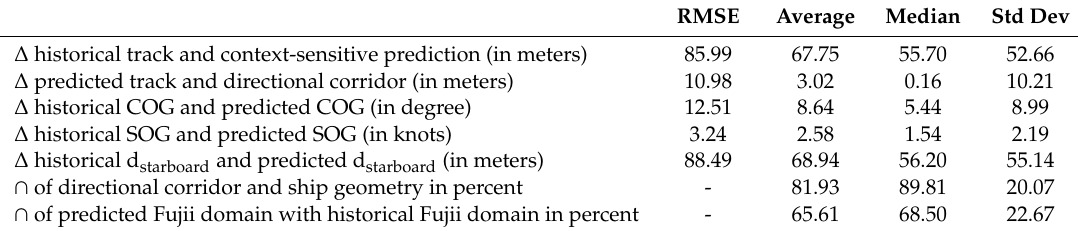
Table 3. Summary of prediction results compared to the actual track. Values in meters. RMSE Average Median Std